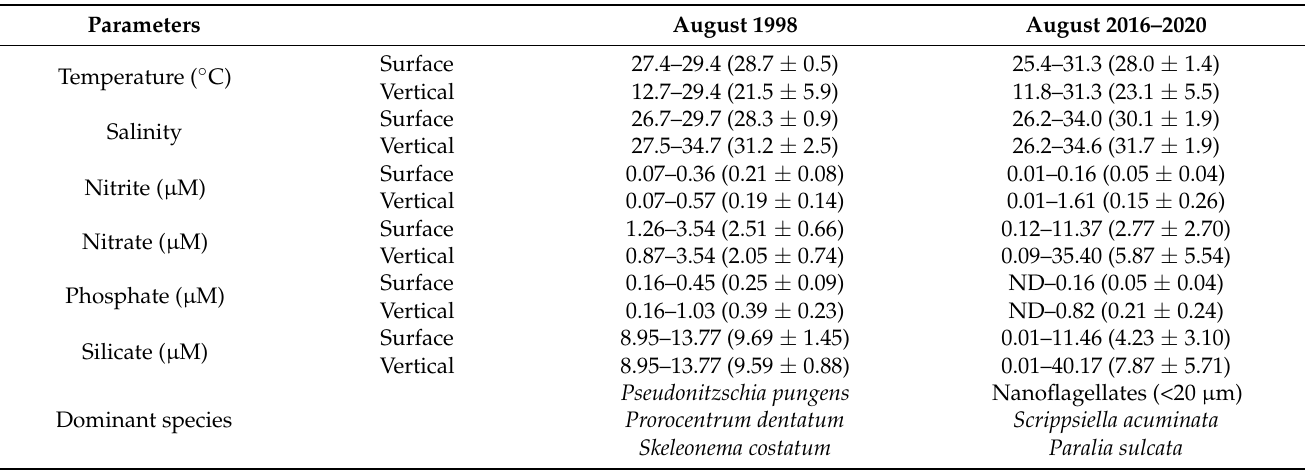
Table 4. Comparison of environmental variables and dominant species in the northern East China Sea between August 1998 [42] and August 2016 to 2020 (this